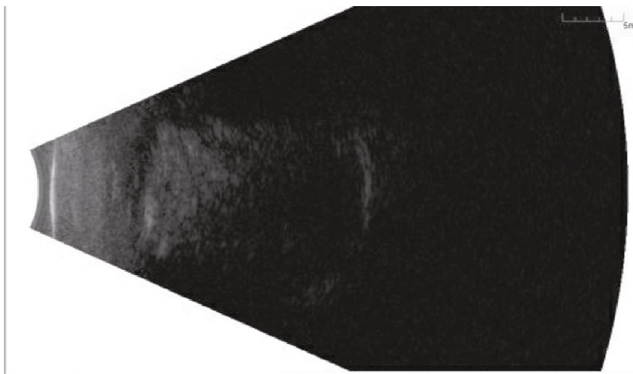
Figure 3: Echography of the patient shows intact